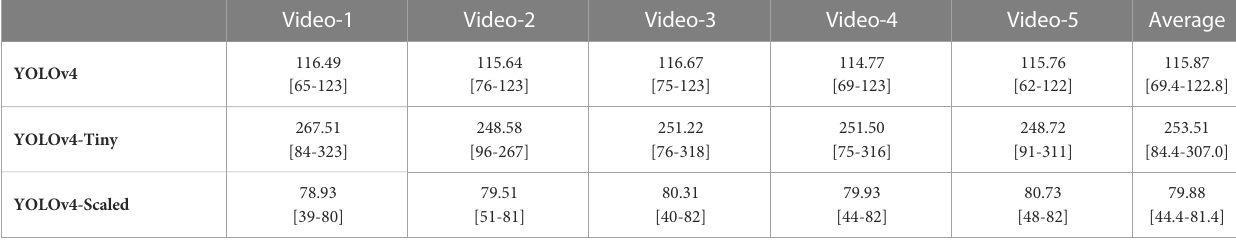
TABLE 6 Comparison of image processing speed between models in frames per second (mean